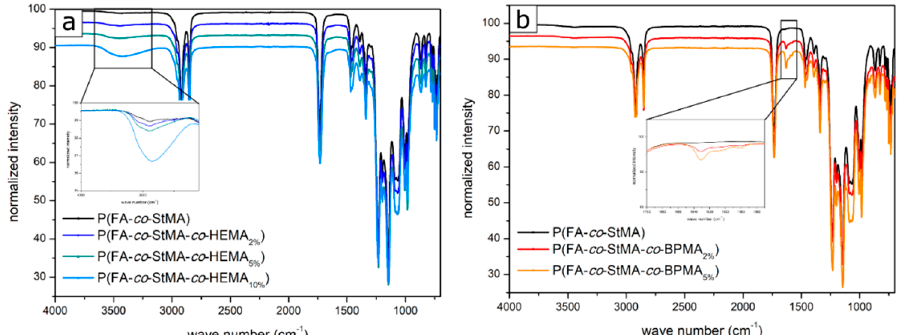
Figure 4. IR spectra of ( a ) the polymers copolymerized with HEMA featuring an increasing signal intensity at 3400 cm − 1 with increasing proportions of HEMA and ( b ) the polymers copolymerized with BPMA with an increasing signal at 1600 cm − 1 with increasing proportions of BPMA.